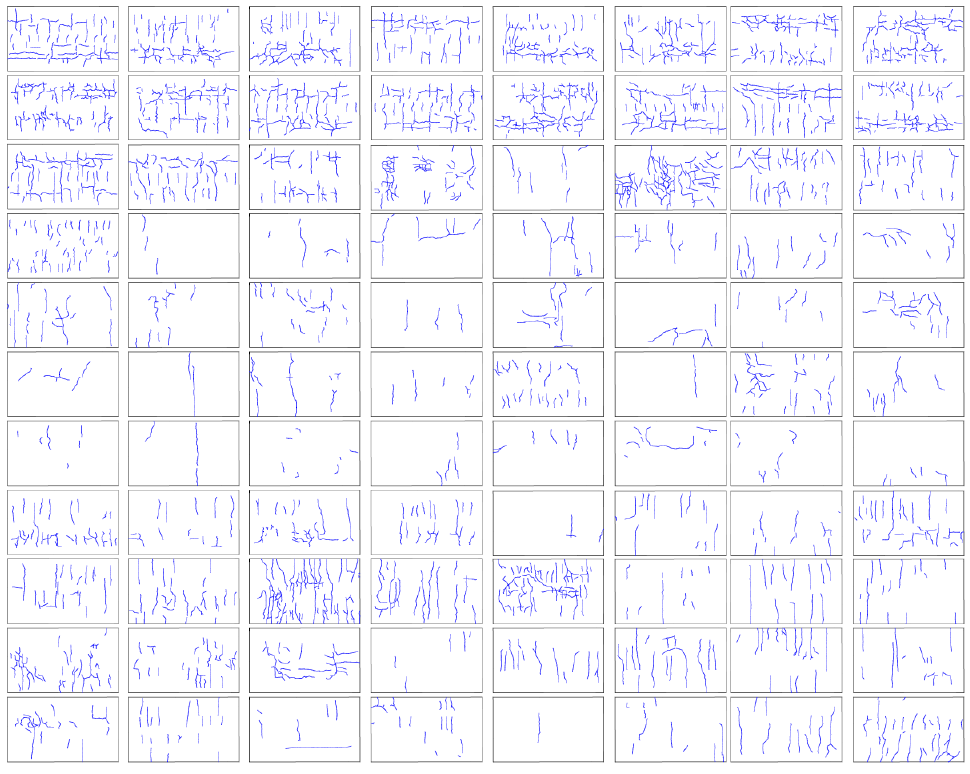
Figure 3. Investigated real crack patterns.